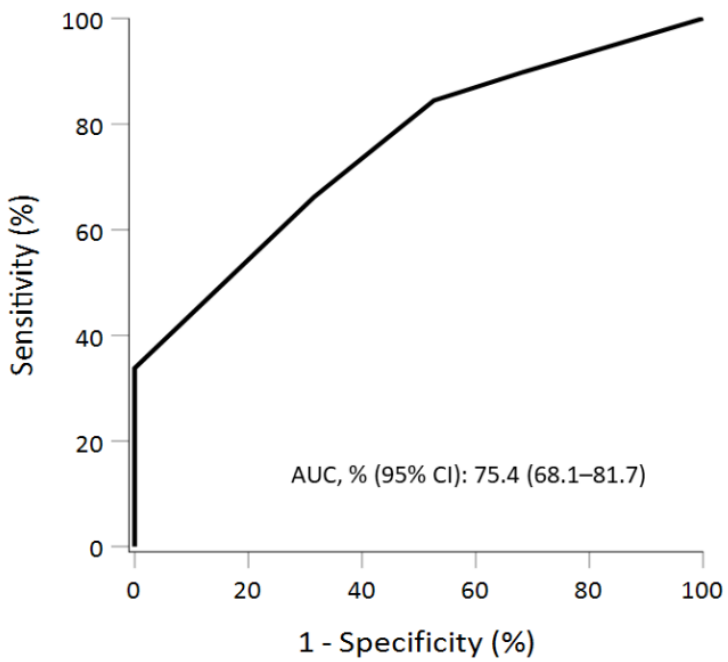
Figure 2. The receiver operating characteristic (ROC) curve of the cytomorphologic scoring. The performance of discrimination was satisfied, with an area under the ROC curve (AUC) of 75.4% (95% CI, 68.1–81.7%).